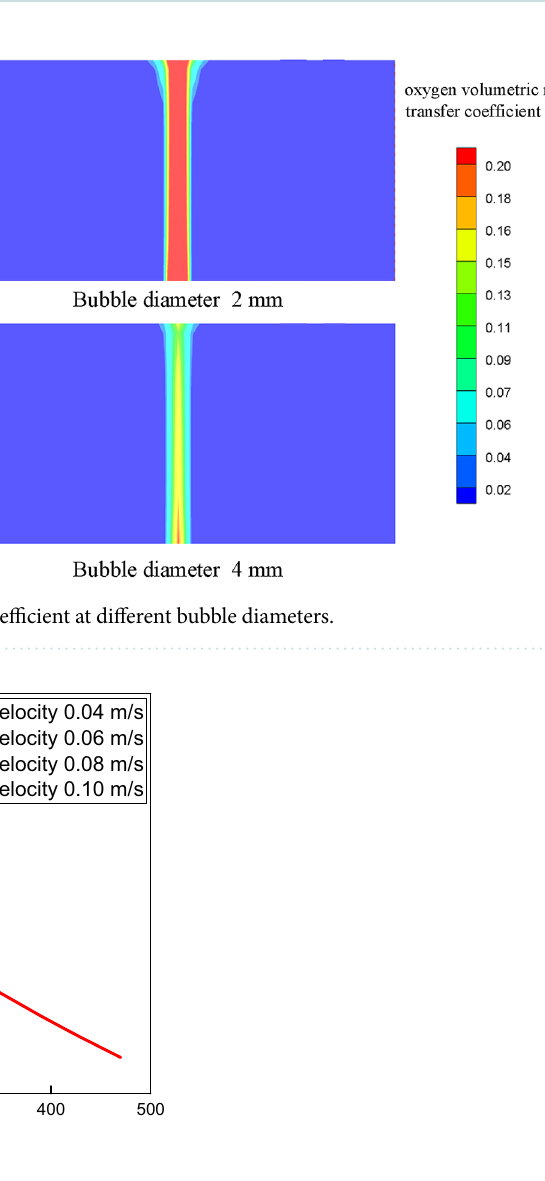
Figure 9. Dissolved oxygen concentration versus scrubbing time at various NEA superficial